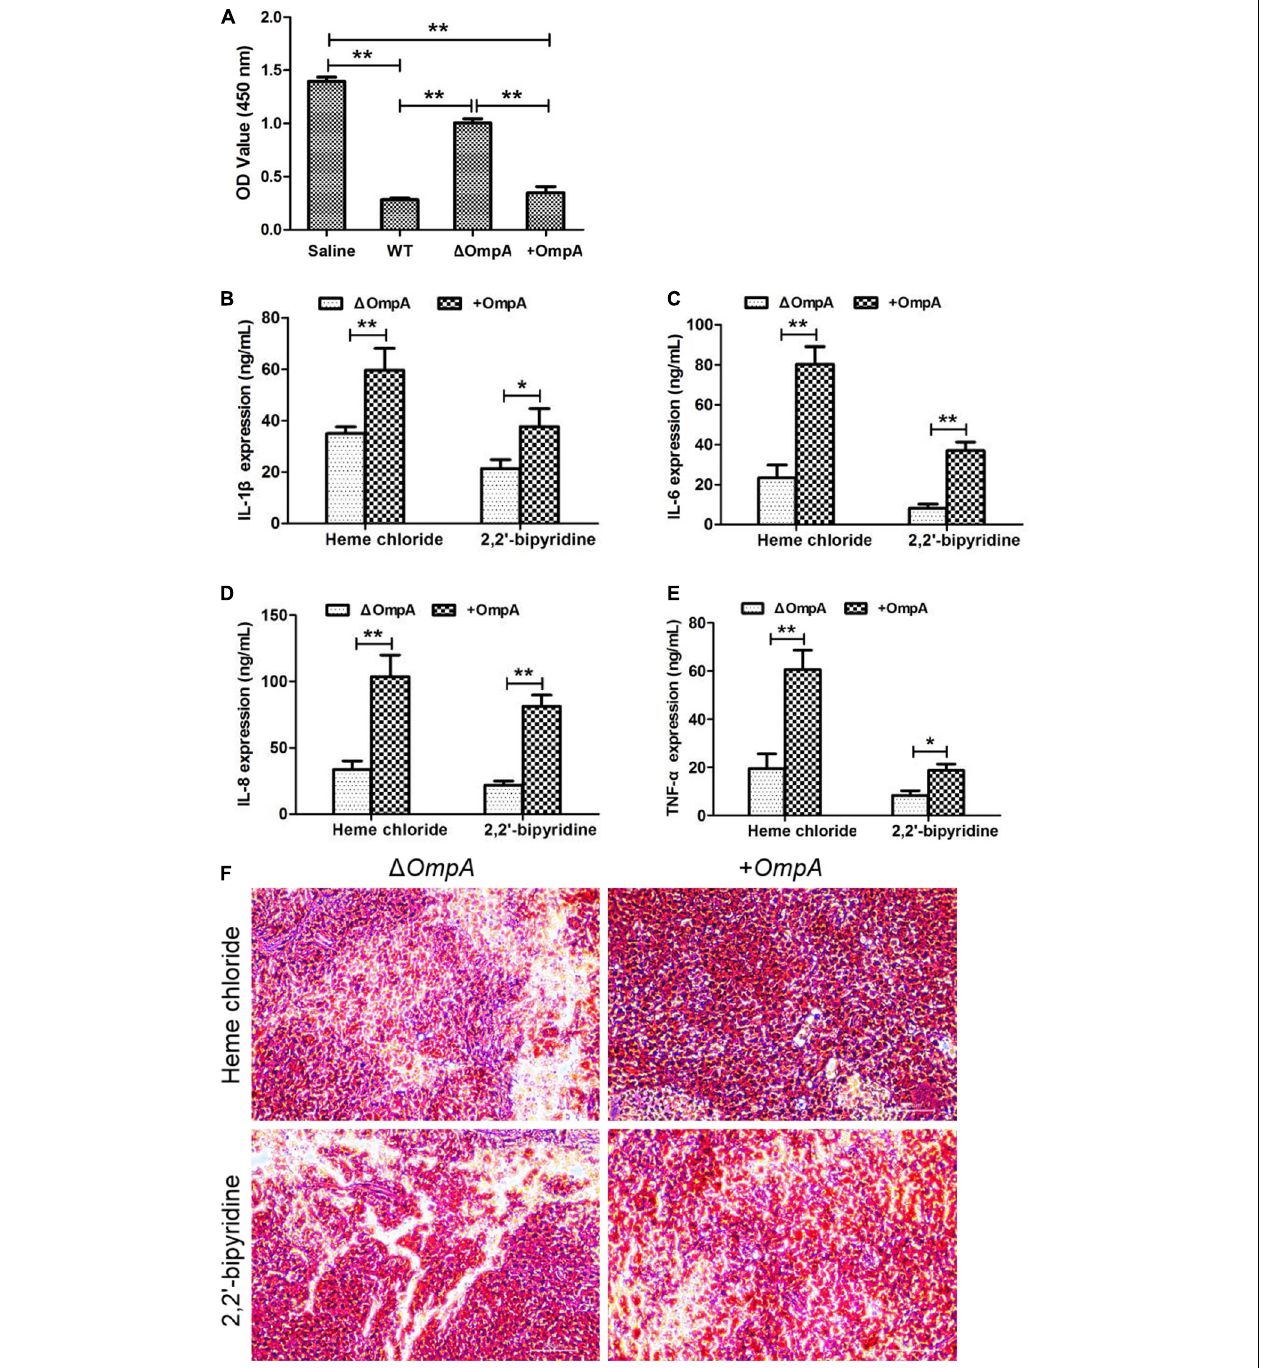
FIGURE 2 | (A) Toxic effect of the (cid:49) ompA and + ompA strains on macrophages. (B–E) The expression levels of inflammatory factors IL-1 β , IL-6, IL-8, and TNF α in the mice spleen were significantly increased in the + ompA strain treatment group compared with the (cid:49) ompA strain group. (F) The picture of spleen tissue grinding and Gram staining. Cells stained in red are bacteria. * P < 0.05 and ** P < 0.01.